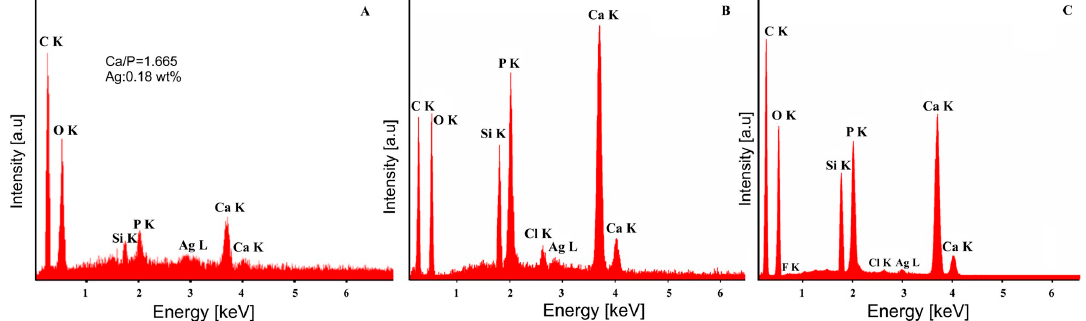
Figure 5. EDX spectra of Ag:HAp ( A ); T-Ag:HAp ( B ) and C-Ag:HAp ( C ) thin films.